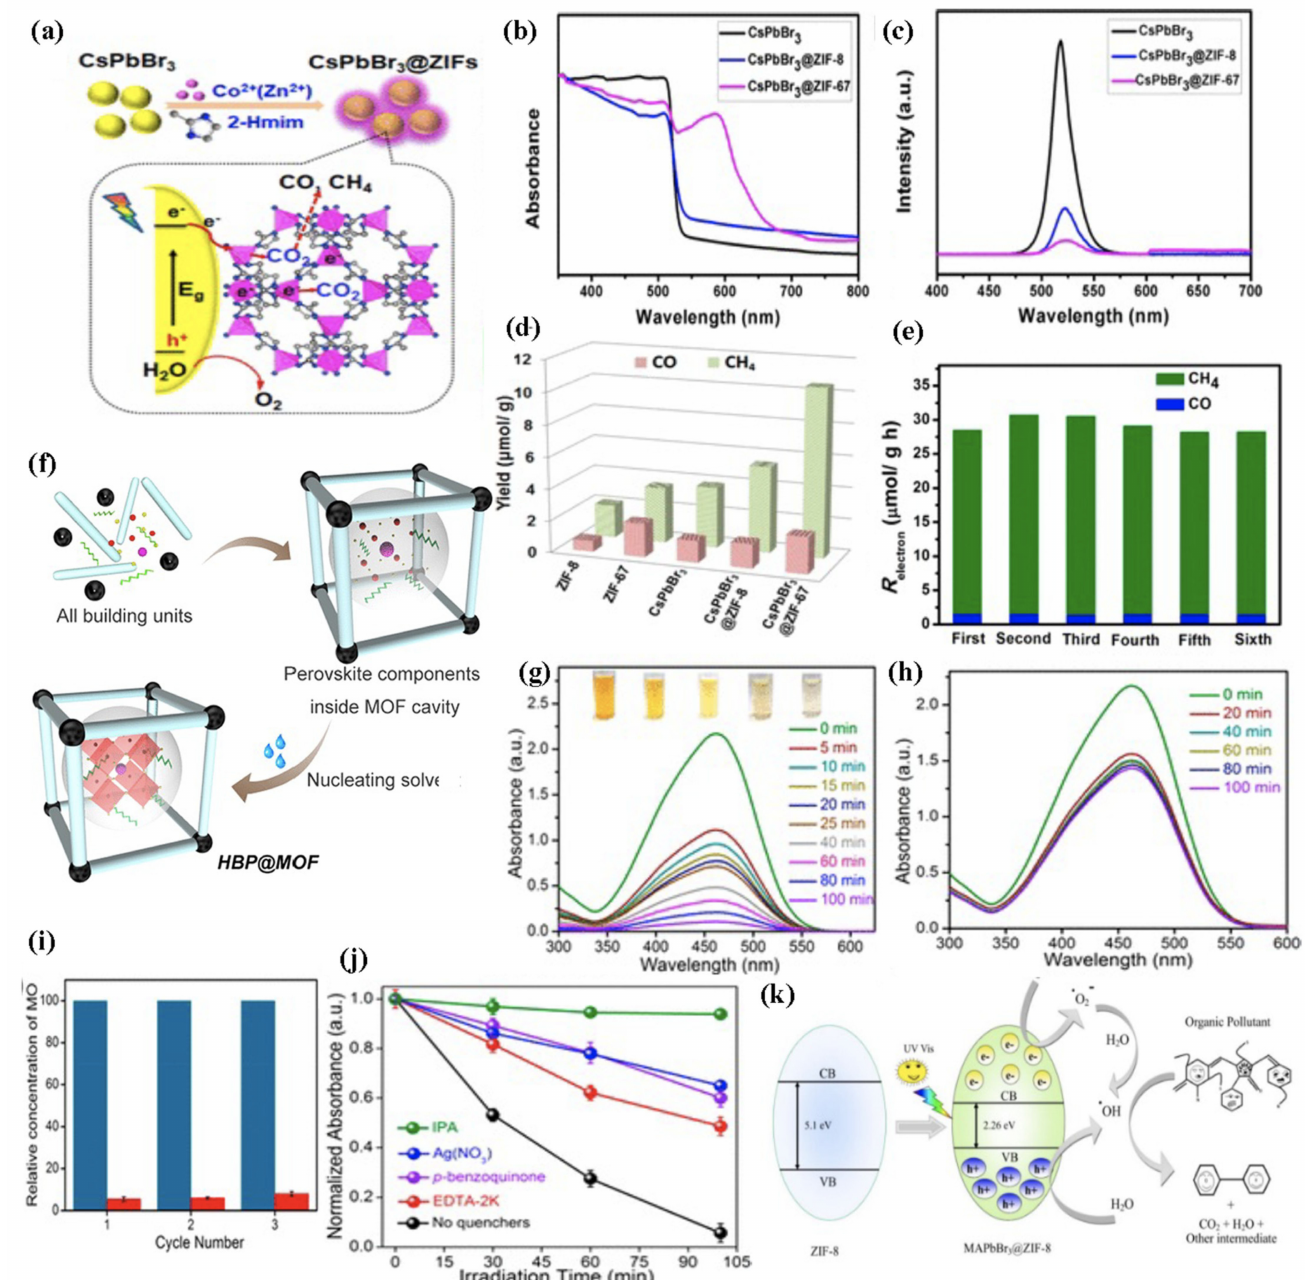
Figure 7. ( a ) Schematic illustration of the fabrication process and CO 2 photoreduction process of CsPbBr 3 /ZIFs. ( b ) UV-vis absorption spectra and ( c ) steady-state PL spectra. ( d ) Product yield after 3 h of photocatalytic reaction and ( e ) recycling test of CsPbBr 3 @ZIF-67 6 times with CO 2 refilled every 3 h. Adapted with permission from ref. [127]. Copyright 2018, American Chemical Society. ( f ) Pore-Encapsulated Solvent-Directed (PSD) procedure for preparing HBP@MOF composites. ( g ) Absorption spectra changes of MO solution degraded by MAPbBr 3 composite under visible light irradiation for different time intervals. The inset photograph shows degradation MO by composite for 0, 10, 25, 60, and 100 min (from left to right) and ( h ) degradation of MO by ZIF-8 under visible light. ( i ) Recyclability test for MAPbBr 3 composite after photocatalytic degradation. The blue colour denotes the concentration of MO molecules before photocatalysis reaction, and the red colour denotes the concentration of MO molecules after photocatalysis reaction and effects of different quenchers for degradation of MO by the composite under visible light. ( j ) The degradation of MO is much prevented for IPA solution (green line), a widely used hydroxyl radical scavenger, confirming that hydroxyl radicals produced during the process are mainly responsible for photocatalytic dissociation of MO. ( k ) Schematic of the photocatalysis reaction mechanism. Adapted with permission from [128]. Copyright 2019, American Chemical